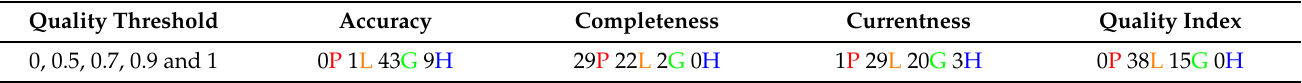
Table 6. Sources quality evaluation